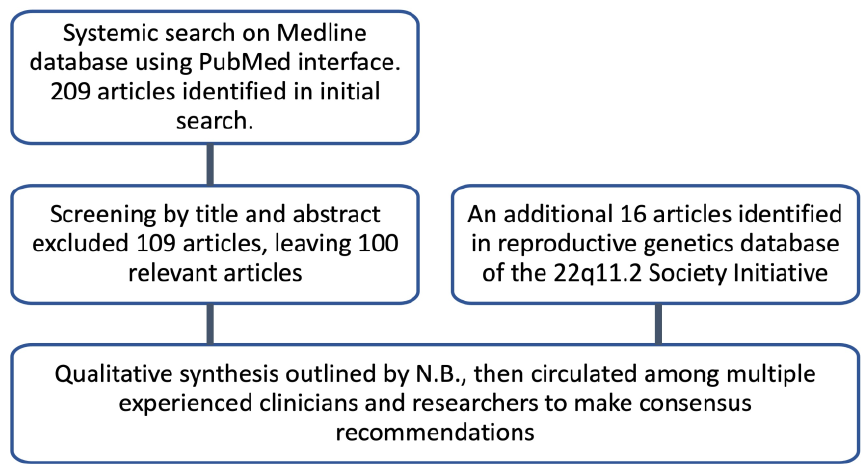
Figure 3. Flow chart of search strategy methods and results.